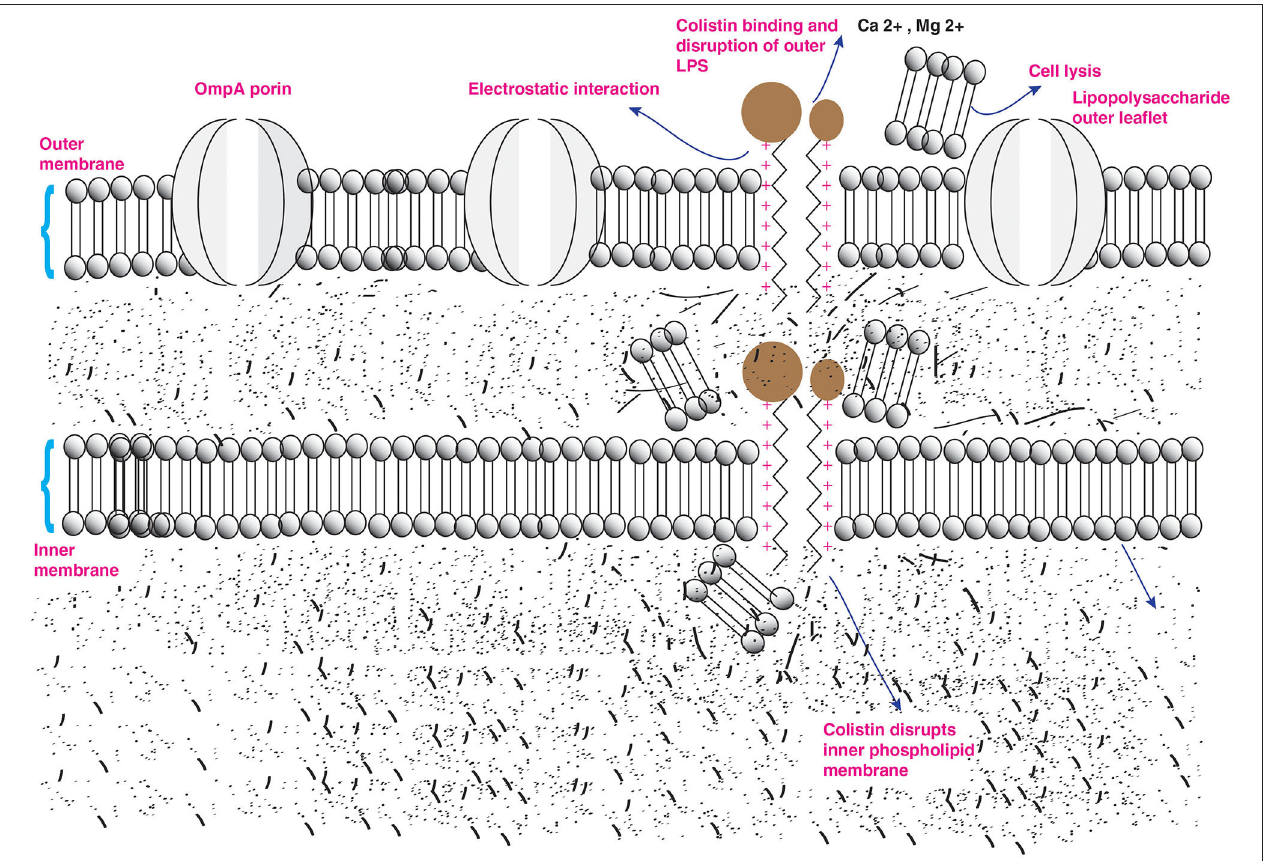
FIGURE 2 | Action of colistin on bacterial membrane. The cationic cyclic decapeptide structure of colistin binds with the anionic LPS molecules by displacing calcium and magnesium from the outer cell membrane of Gram-negative bacteria, leading to permeability changes in the cell envelope and leakage of cell contents.